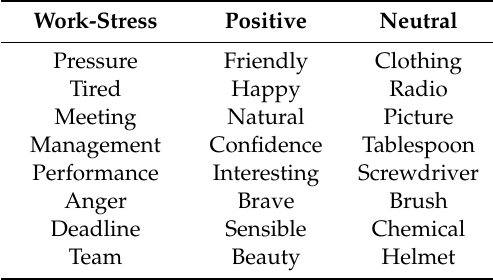
Table A1. Words used in the Work-Stress Memory Task for each word